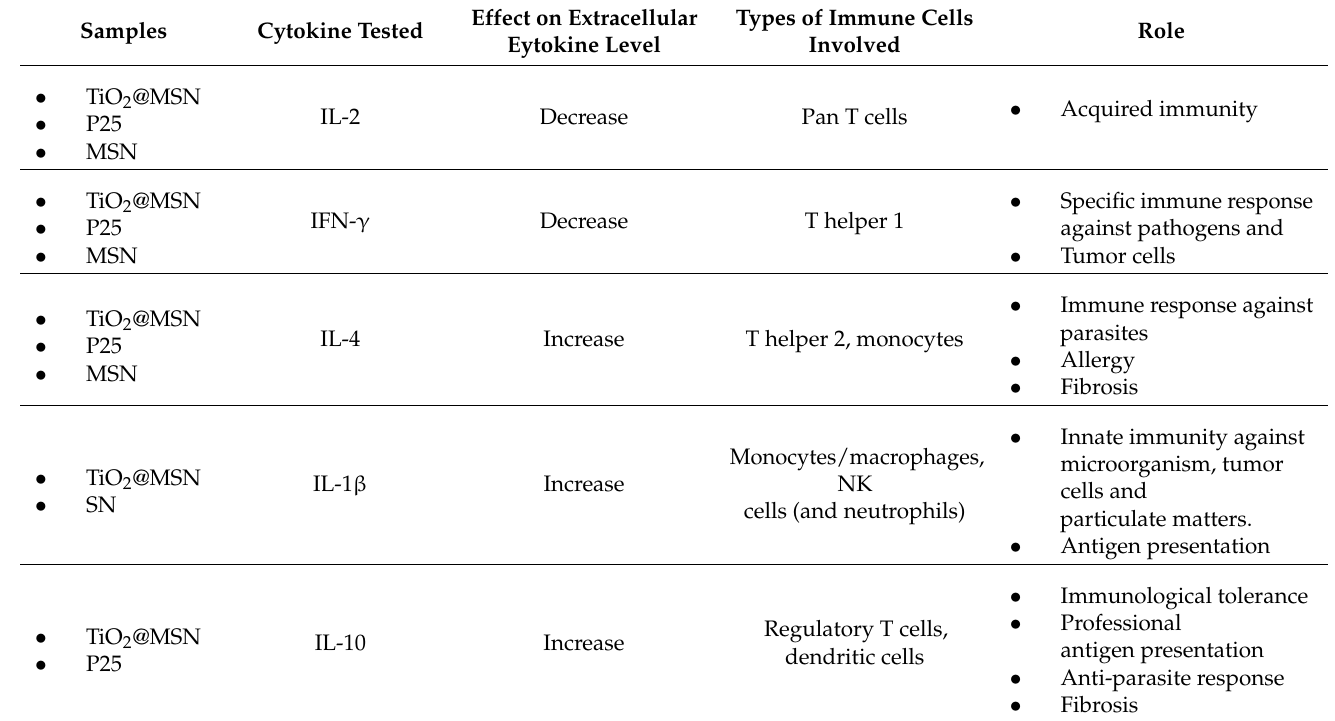
Table 2. Dose-dependent cytokine patterns associated with exposure of PBMC to TiO 2 @MSN, MSN and P25 and their target cells of the immune system.